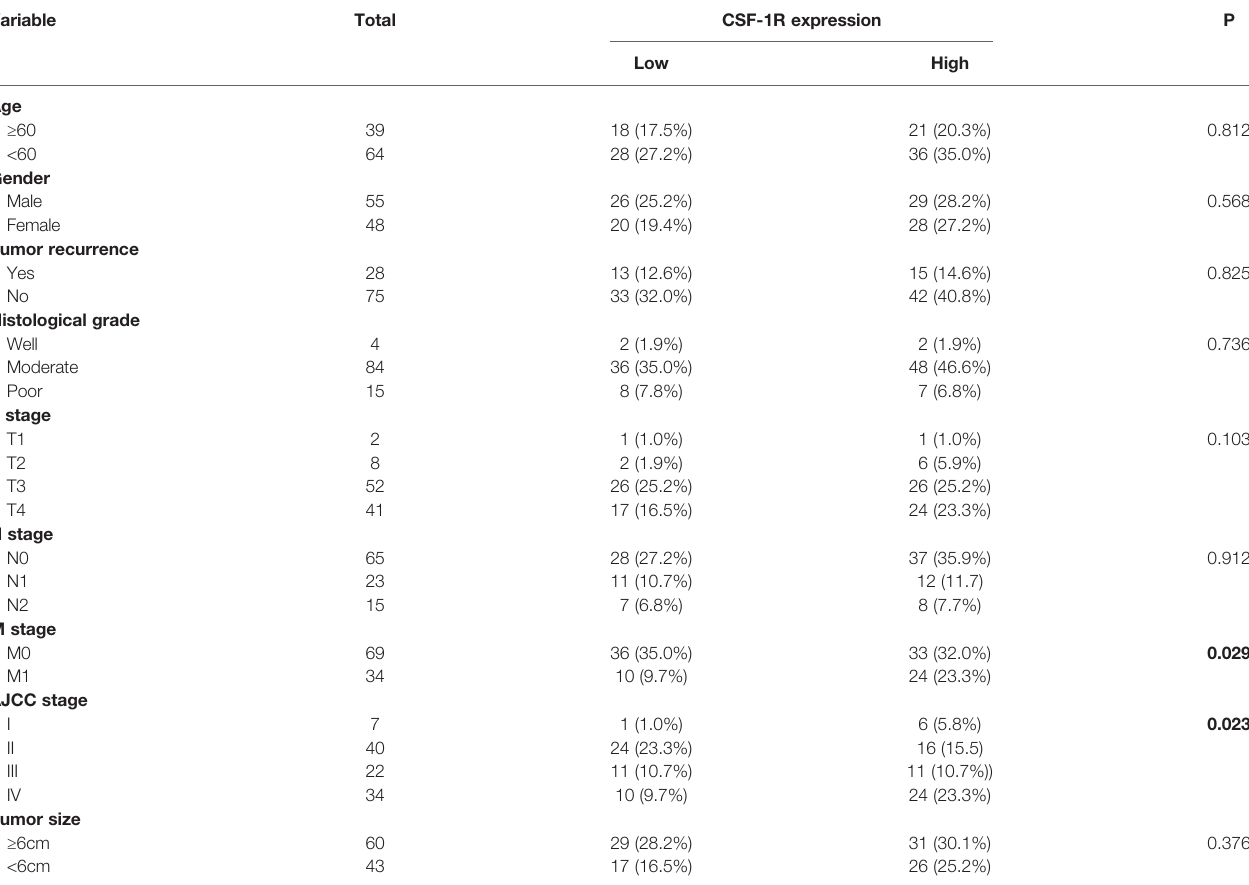
TABLE 1 | Associations between CSF-1R expression and clinicopathological characteristics in 103 COAD patients.